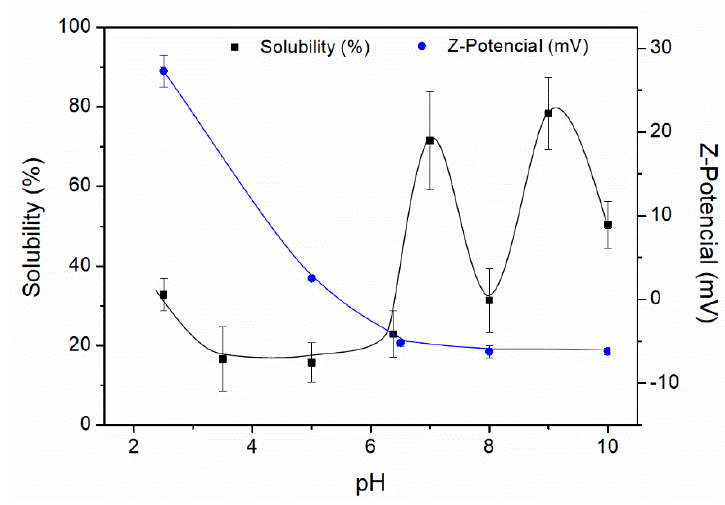
Figure 1. Protein solubility (%) and Z-Potential (mV) of the collagen protein isolate.